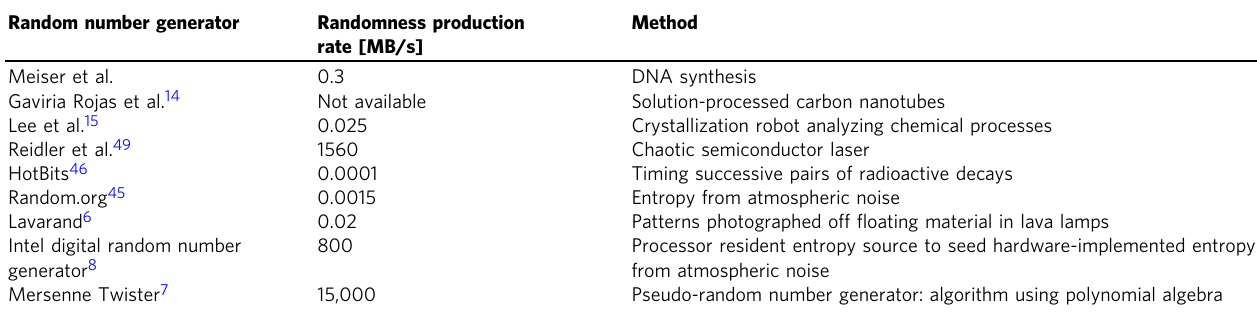
Pseudo-random number generator: algorithm using polynomial